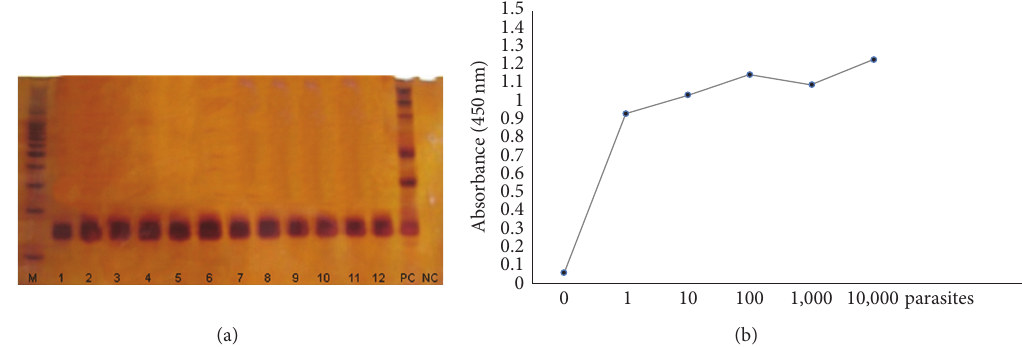
Figure 2: Analytical sensitivity of conventional PCR and kDNA PCR-ELISA in spiked blood samples. (a) Analytical sensitivity of 6% polyacrylamide gels and (b) kDNA PCR-ELISA for the detection of PCR products from DNA extracted from spiked blood samples with the addition of 1 parasite (lines 1 and 2) and 10 (lines 3 and 4), 100 (lines 5 and 6), 1,000 (lines 7, 8, and 9), and 10,000 parasites (lines 10, 11, and 12); PC: positive control, NC: negative control, and M: 100 pb DNA Ladder (Promega). The absorbance readings correspond to the mean of the duplicate for each parasite